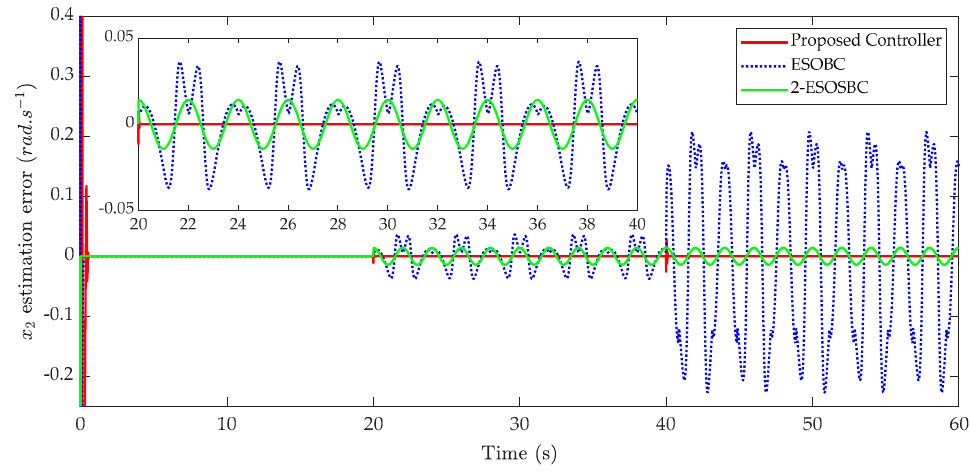
Figure 6. The estimation error of the angular velocity of the inertial load.